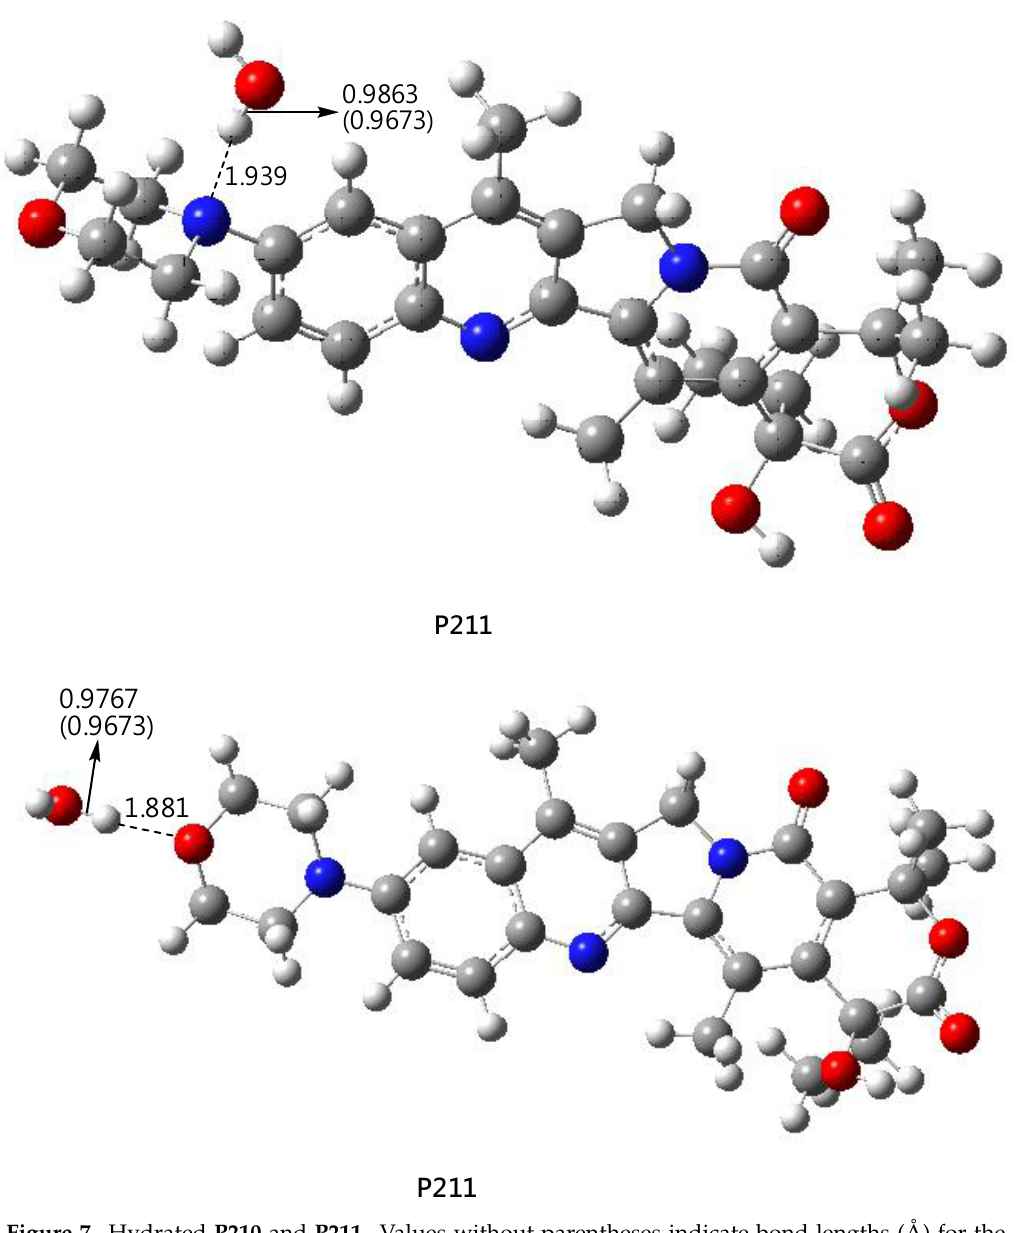
Figure 7. Hydrated P210 and P211 . Values without parentheses indicate bond lengths (Å) for the water/CPT derivative system; values in parentheses indicate bond lengths (Å) for the free molecules (carbon in gray, nitrogen in blue, oxygen in red, and hydrogen in white) .